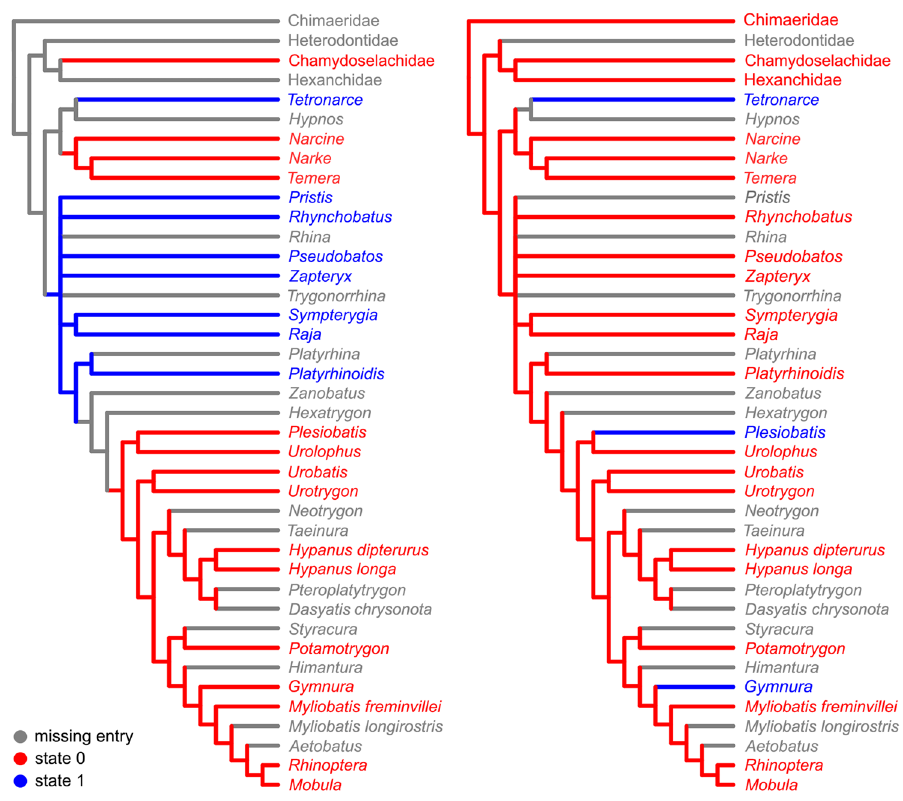
afferent branchial arteries with Aschliman’s et al. 3